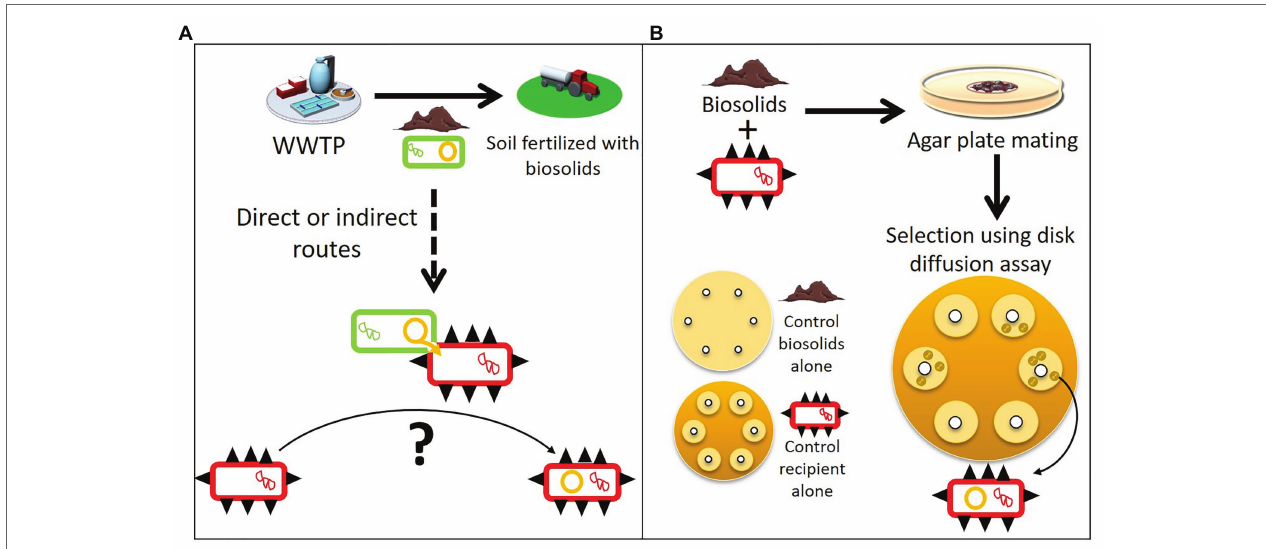
FIGURE 1 | Spreading of plasmids within a mobile resistome and a modified plasmid capture method to isolate them. (A) Biosolids from wastewater treatment plants (WWTPs) used as agricultural soil fertilizer contain bacteria (green rectangles) with resistance plasmids (orange circles). These biosolids can spread the resistance plasmids further, and through direct or indirect routes transfer to human pathogen and commensal bacteria (red rectangles with black spikes). (B) To determine the mobile resistome of biosolids that can be acquired by human pathogens and commensal bacteria, we used a modified exogenous plasmid isolation approach. Biosolids were mixed individually with different ESKAPE pathogens or E. coli (the recipient hosts). After overnight incubation, the mixtures were spread on a large selective agar plate and stamped with about 10 antibiotic disks. Recipient hosts that acquired a new resistance plasmid from the biosolids formed colonies in the inhibition zone where the recipient alone was sensitive (“control recipient alone”). Assays with biosolids alone were also run in parallel to control for false positives (“controls biosolids